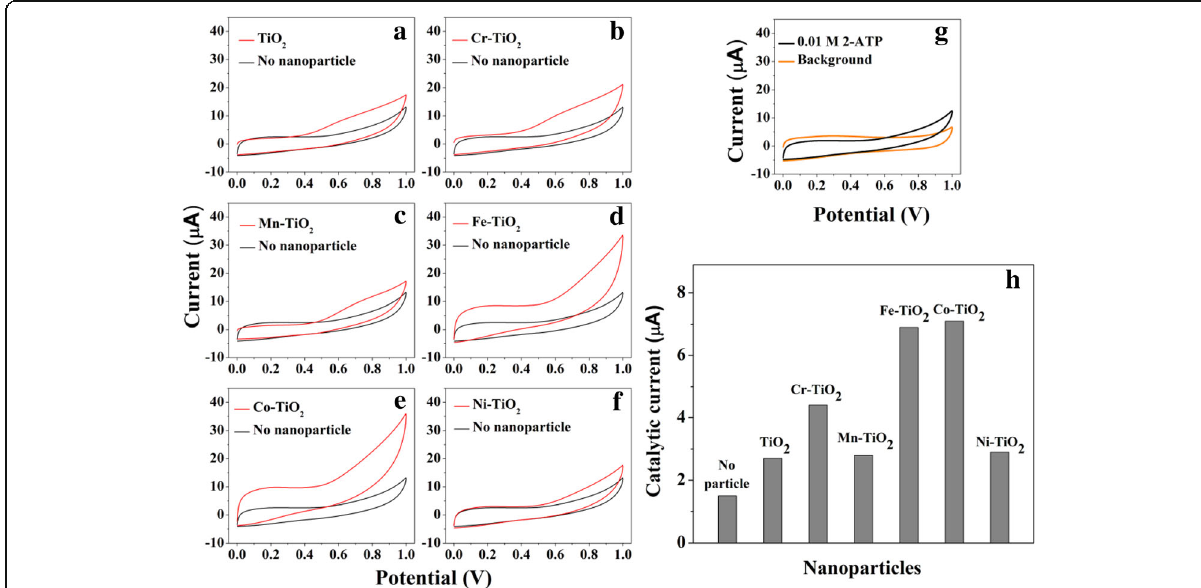
Fig. 5 a – f CVs (at a scan rate of 50 mV/s) in PBS containing 0.01 M 2-ATP at a bare GCE (black lines) or GCEs modified (red lines) with 5 mol% a anatase TiO 2 , b Cr-TiO 2 , c Mn-TiO 2 , d Fe-TiO 2 , e Co-TiO 2 , and f Ni-TiO 2 . g A sluggish oxidation current observed at a bare GCE because of the intrinsically slow oxidation of 2-ATP. h Catalytic currents resulting from the electrochemical oxidation of 2-ATP for the various types of anatase TiO 2 and the five TM-TiO